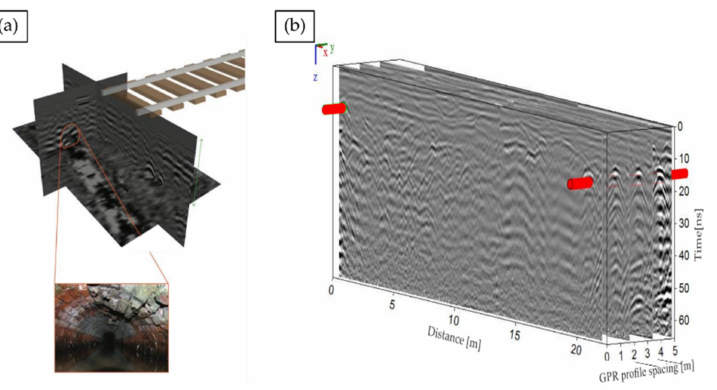
Figure 5. Principal methodology for combining planar radargrams to form pseudo-3DGPR visuals. ( a ) Orthogonal Intersection: B-scans meet at 90 ◦ helps focus attention on the central region. ( b ) Parallel Stacking: Aligning B-scans as slices of a cuboidal volume helps identify reoccurring targets [97].